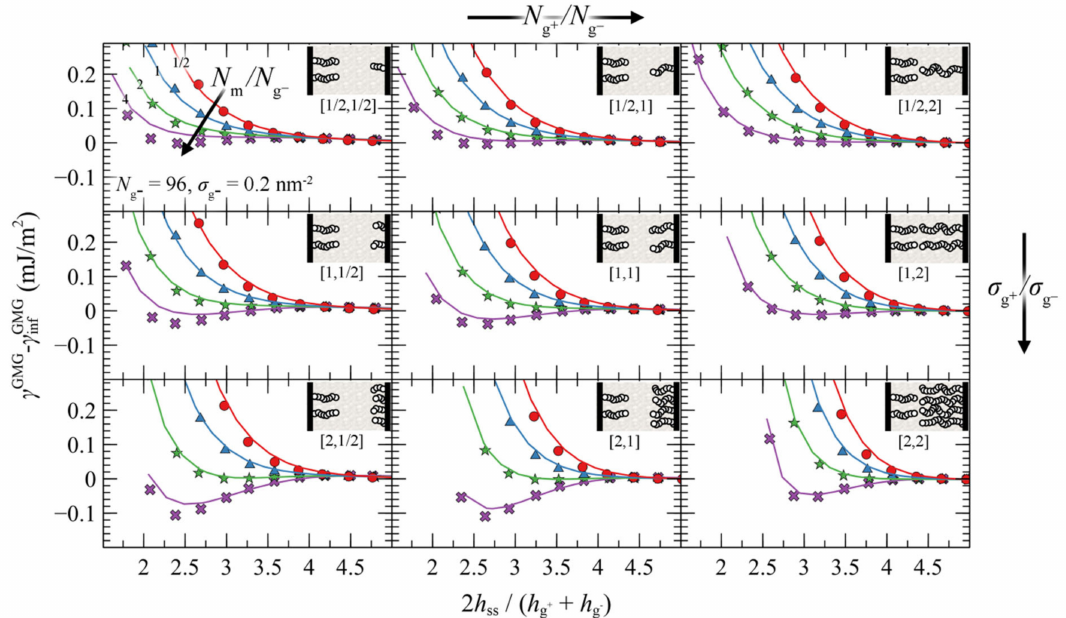
Figure 10. Potential of mean force against the reduced surface-surface distance for approaching grafted silica surfaces with σ g − = 0.2 nm − 2 and N g − = 96. Colors correspond to evaluations for N m / N g − = 1/2 (red), 1 (blue), 2 (green) and 4 (purple), and the labels in brackets denote the ratios σ g + / σ g − and N g + / N g − . Lines and markers correspond to evaluations with the HFD and SL EoS, respectively. Inset: each bead denotes a segment of 24 PS